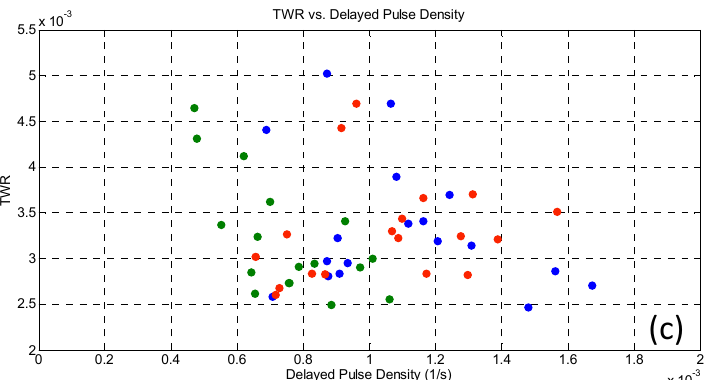
Figure 11. TWR versus ( a ) normal, ( b ) arc, and ( c ) delayed pulse density: blue dots refer to gap = 40, red dots to gap = 60, and green dots to gap = 80.